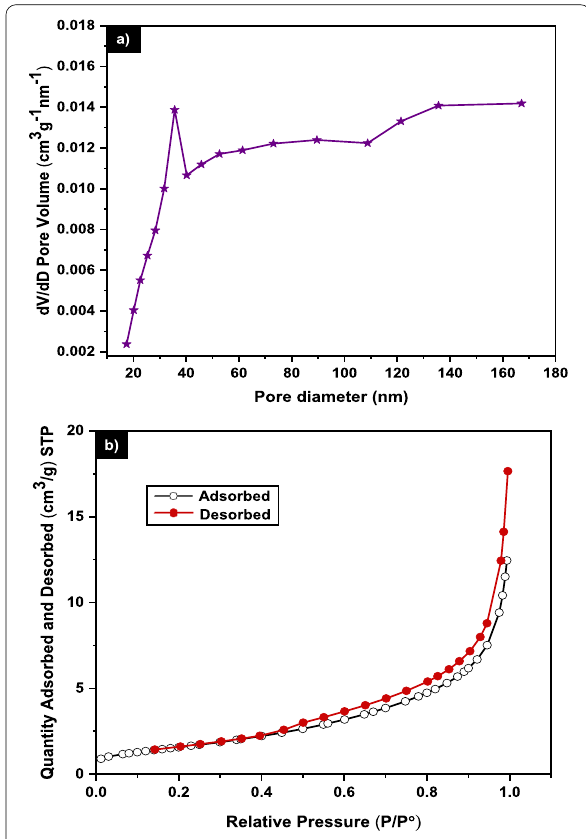
Fig. 6 a Distribution of pore diameter of 7 h MNA b Nitrogen adsorption–desorption